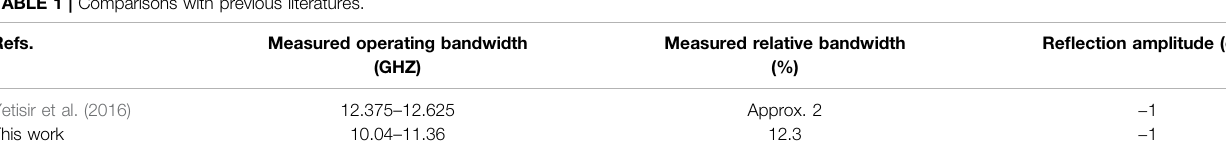
TABLE 1 | Comparisons with previous literatures.